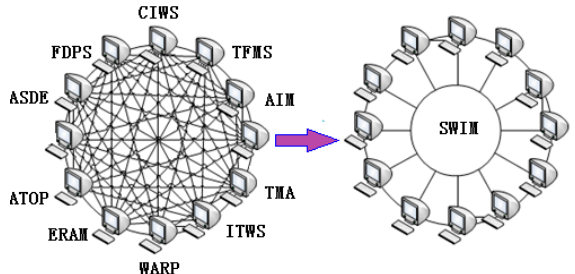
Figure 1. Traditional mesh communication structure (left) and System Wide Information Management (SWIM) bus communication structure (right) comparison chart.